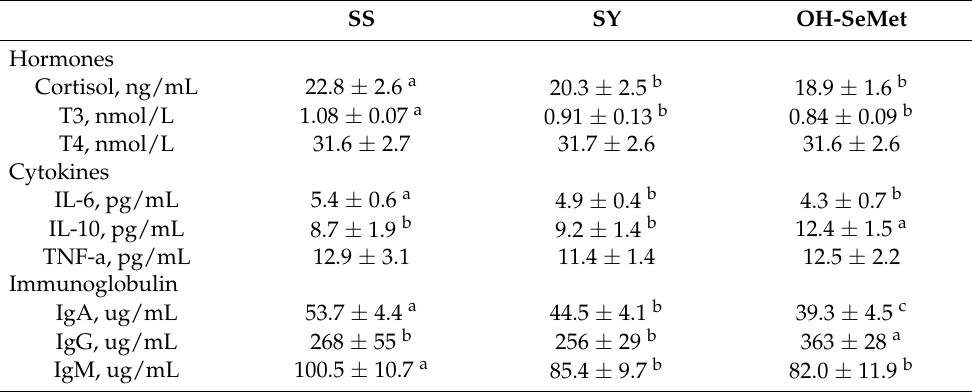
Table 2. Effects of the three selenium forms on the biochemistry in the serum of the chicks 1 .